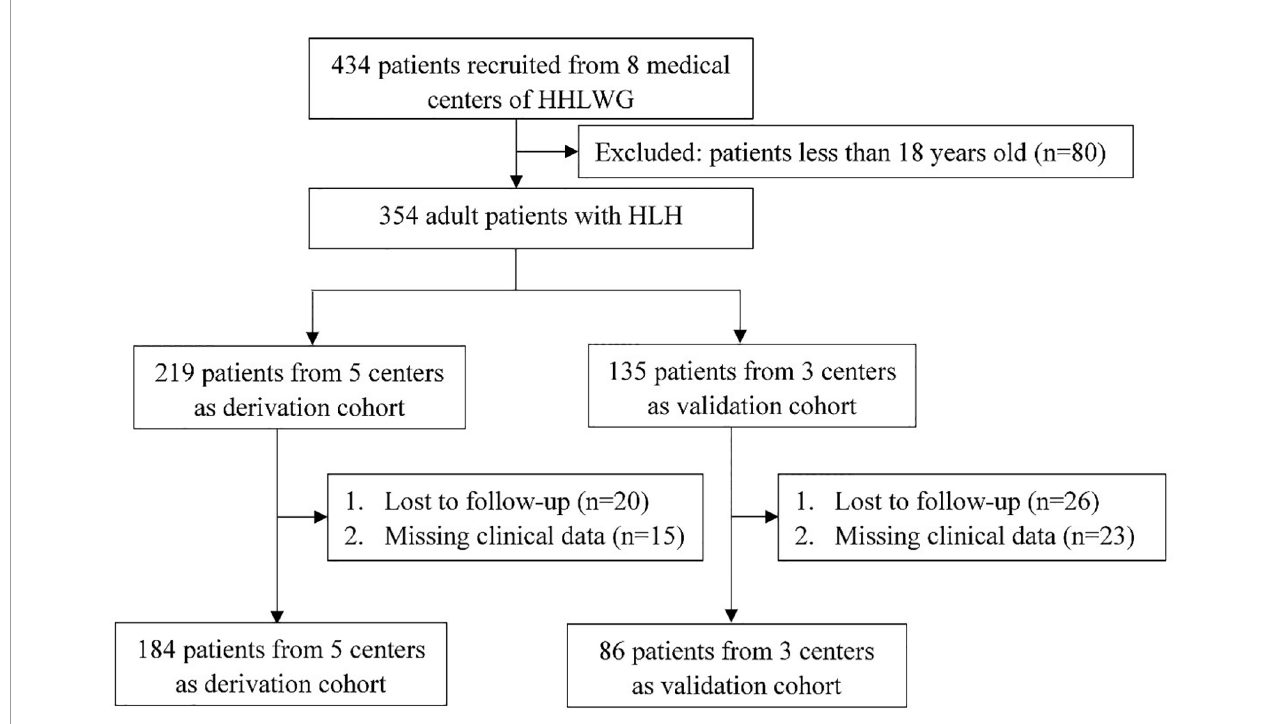
FIGURE 1 | Flow chart of screening patients with